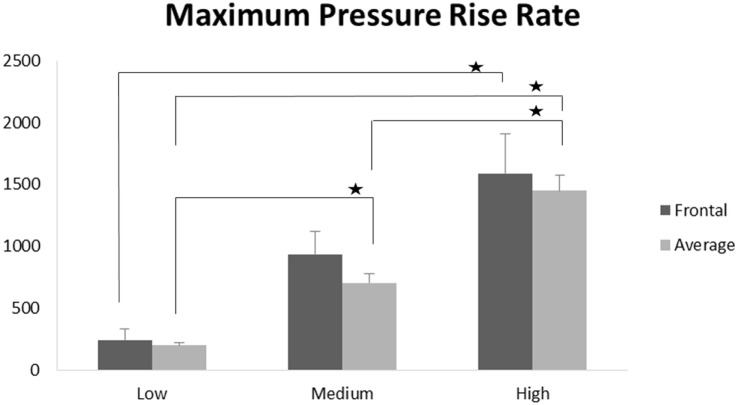
Maximum pressure rise rates were significantly increased with increasing blast levels both in the frontal region and when averaged across all five locations (*p < 0.05).